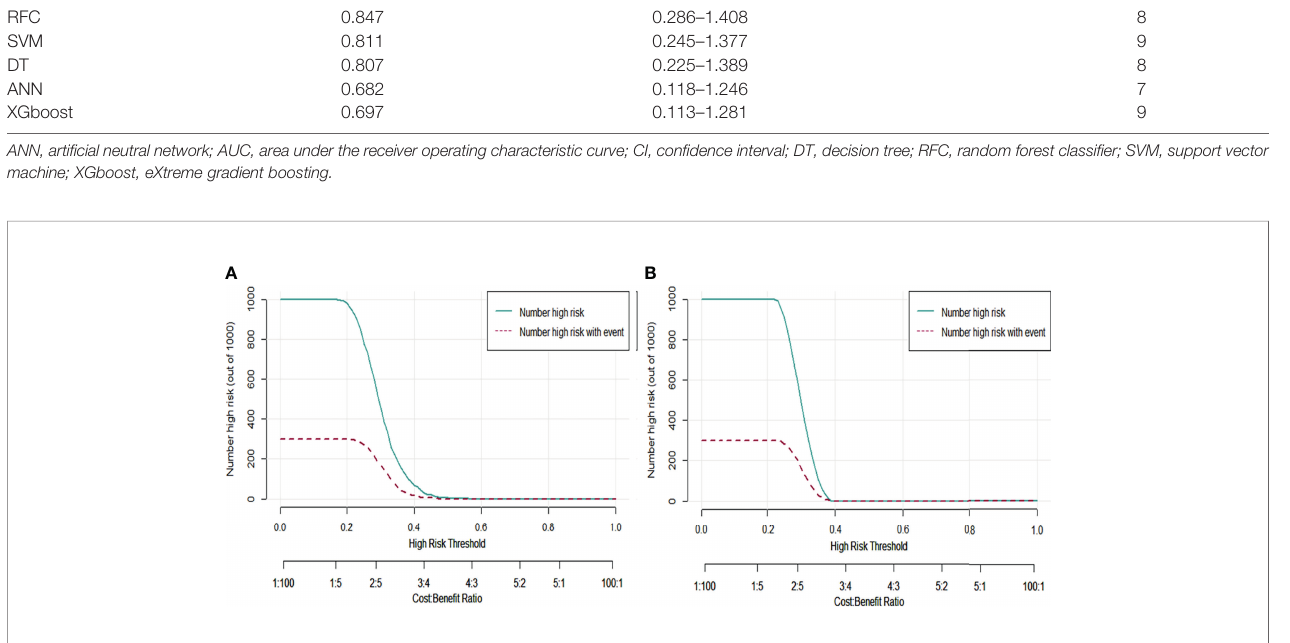
FIGURE 5 | Predictive performance of the RFC model evaluated with the CIC. (A) Training set. (B) Validation set. The dark green line predicts the probability of poor rNACT, and the purple line shows the number of patients at high risk of